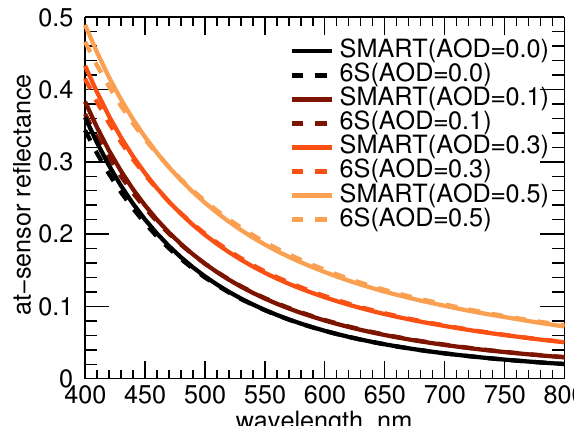
Fig. 6. Results of the at-sensor reflectance function R S , TOA Fig. 6: Results of the at-sensor reflectance function R S , TOA λ λ (Eq. 22) computed by SMART (solid line) and 6S (dashed line) at (Eq. 22) computed by SMART (solid line) and 6S (dashed TOA, SZA=30 ◦ and varying τ aer . SMART uses the HG phase line) at TOA, SZA=30 ◦ and varying τ aer . SMART uses 550nm 550 nm function, while 6S uses the phase function from Mie theory. Re- the HG phase function, while 6S uses the phase function maining input parameters are given in Table from Mie theory. Remaining input parameters are given in Table 2.